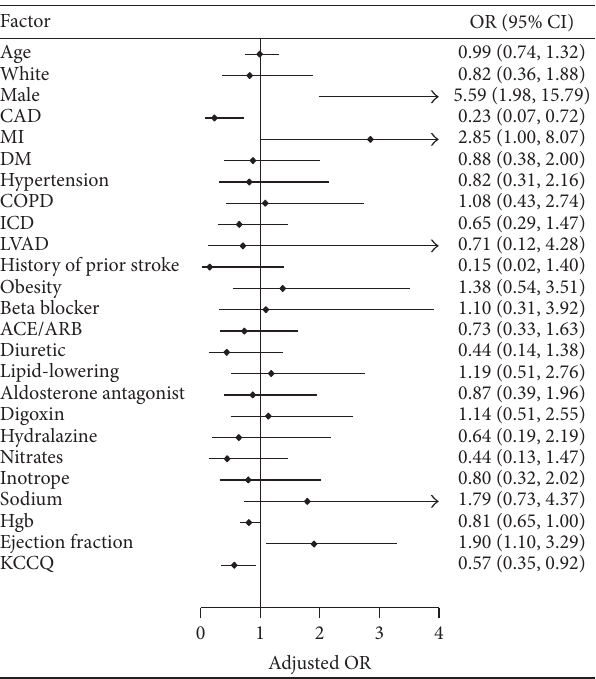
Figure 1: Adjusted odds ratios of readmission within 30 days after discharge derived from multivariate logistic regression analysis.